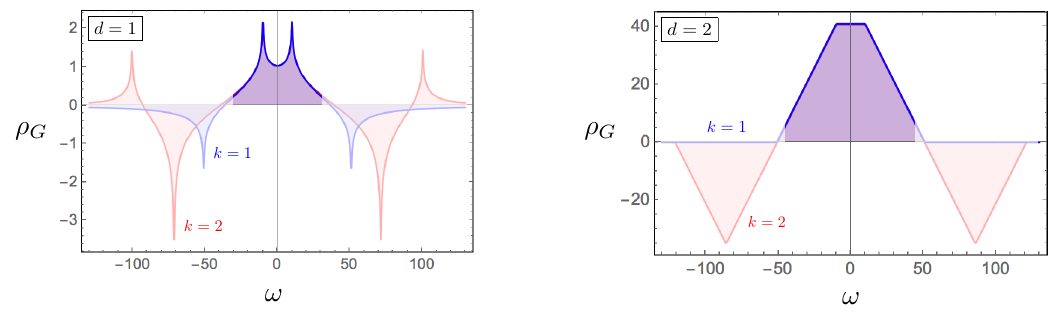
) 2 + ν 2 , ν = 10 , for d = 1 , 2 in k = 1 , 2 2 Λ . The peaks/kinks &